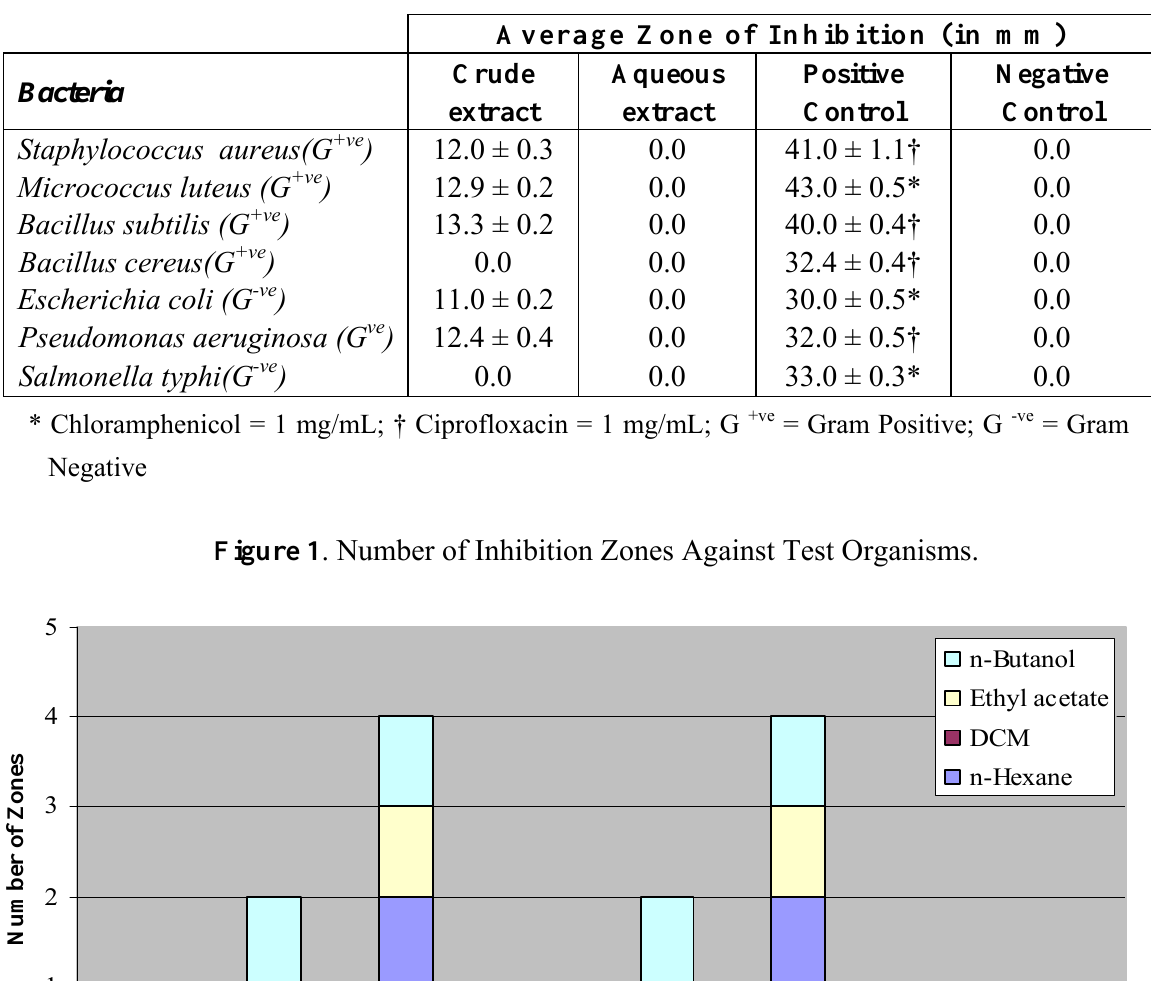
Table 1 . Antibacterial activity of Crude and Aqueous Extracts of Dodonaea viscosa.